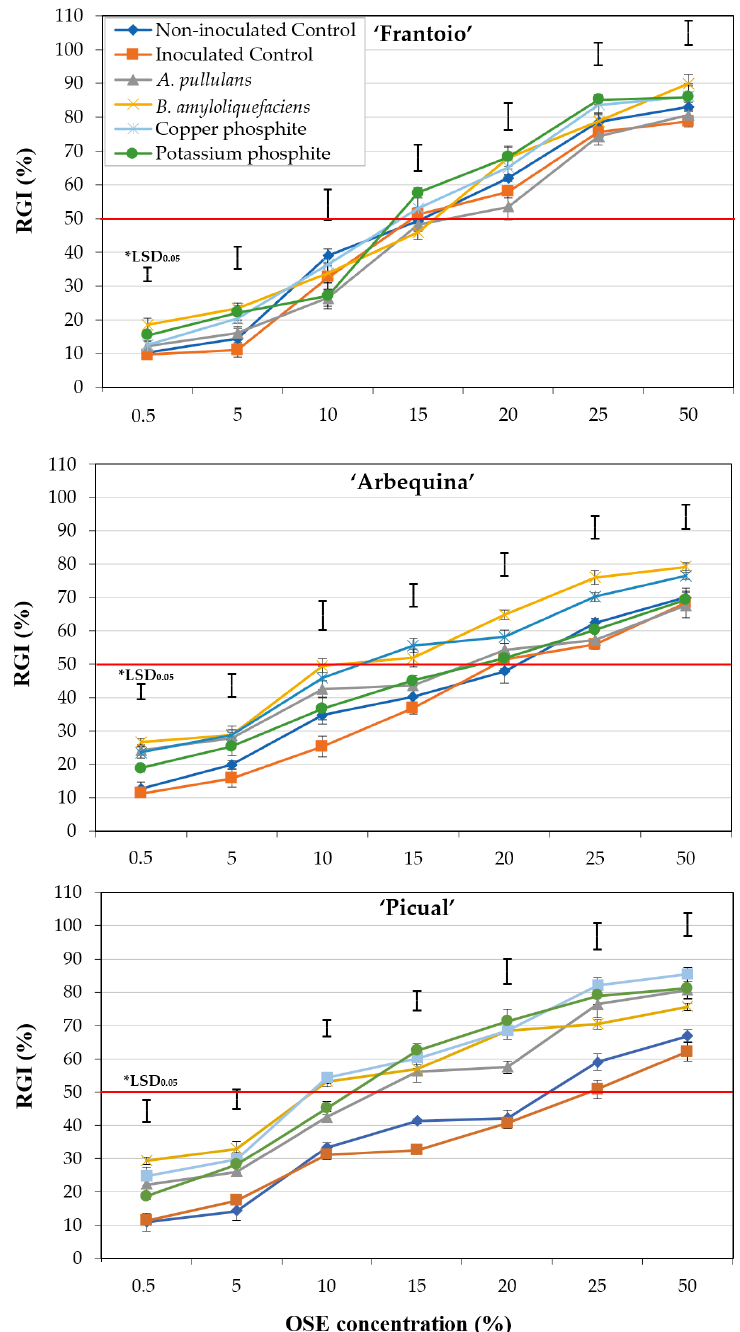
Figure 3. Effect of olive stem extract (OSE) from healthy olive plants of cvs. Frantoio, Arbequina, and Picual treated by root applications with the most effective compounds from Experiment II ( Au ‐ reobasidium pullulans , Bacillus amyloliquefaciens , copper phosphite, or potassium phosphite) and from non ‐ treated control plants, both non ‐ inoculated and inoculated with Verticillium dahliae isolate V ‐ 180 on the relative conidial germination inhibition (RGI) of V. dahliae isolate V180. In each graph, data are the means of 240 conidia (six replicates) per combination of olive cultivar and OSE concen ‐ tration. Vertical bars represent the standard error of the means. *LSD bars represent the critical val ‐ ues for comparison at P = 0.05. Table 3. Effective concentrations of olive stem extract (OSE) from cvs. Frantoio, Arbequina, and Picual and treated with the most effective compounds to inhibit 50% of conidial germination (EC 50; μ L ml − 1 ) of Verticillium dahliae isolate V180.